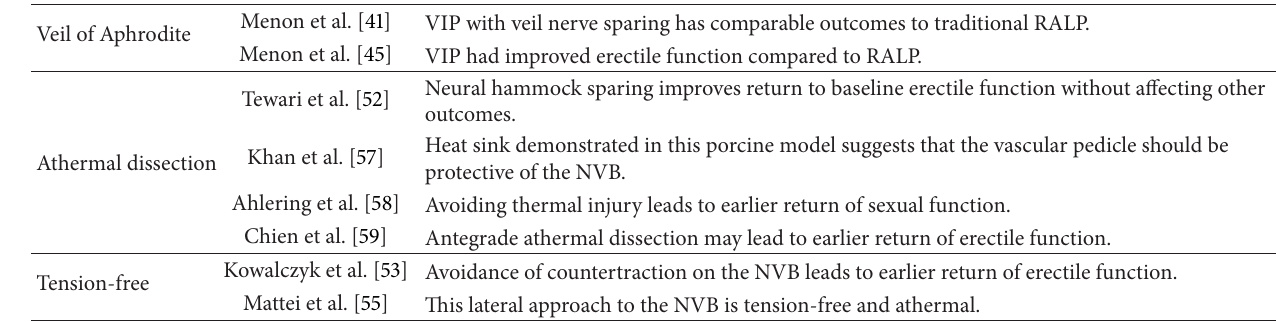
Table 4: Neurovascular bundle